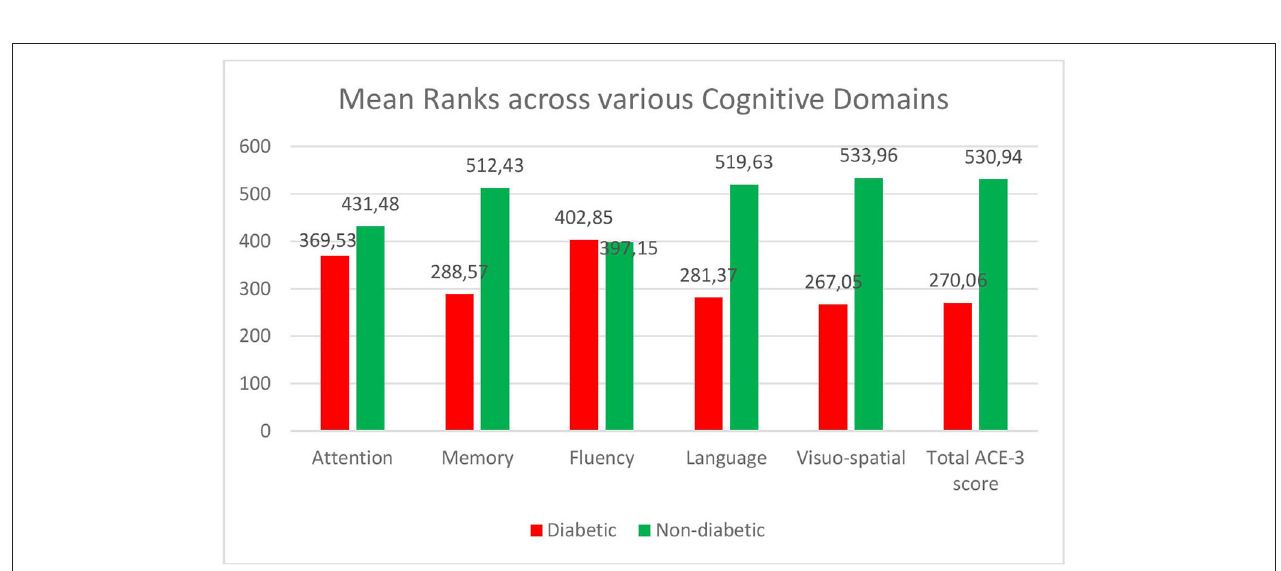
FIGURE 1 | Comparison of various cognitive domains across diabetics and